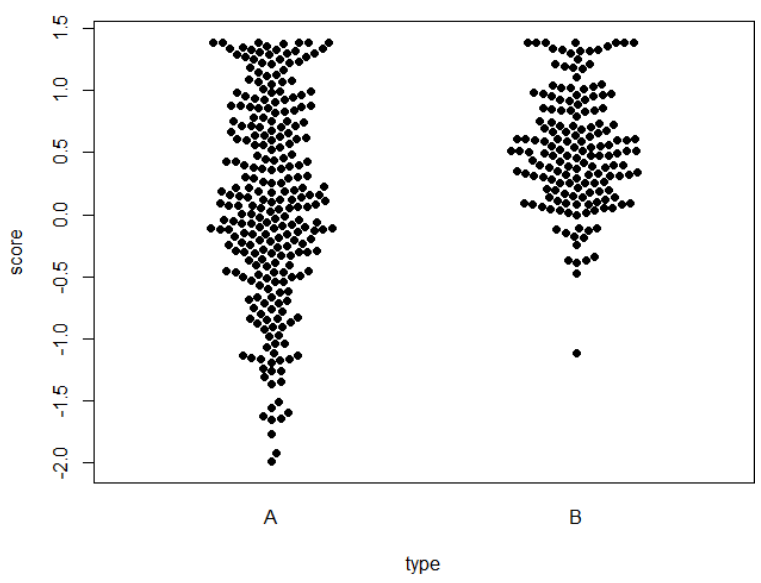
Figure 9. The bee colony diagram about the log-scores for the two types of cells.